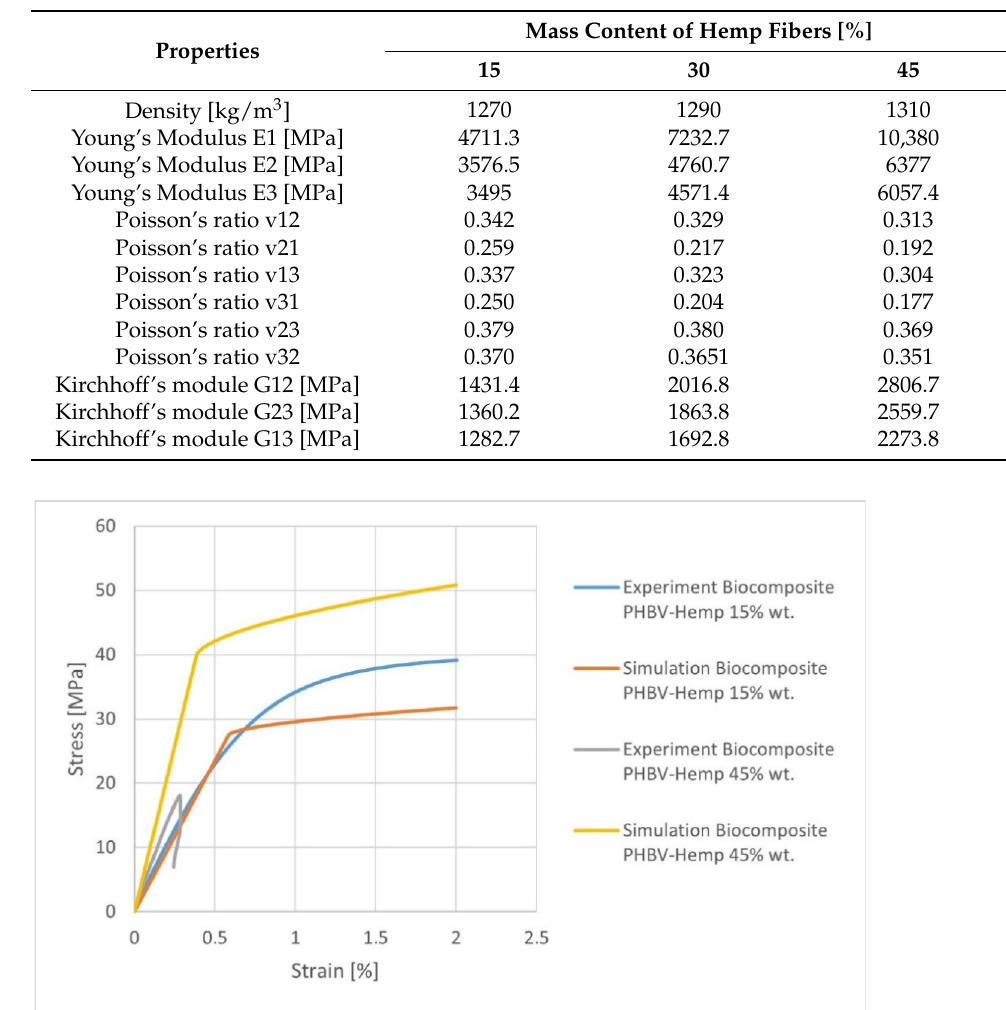
Table 11. The predicted properties of the biocomposite PHBV-hemp fiber for variable types of fiber geometry in RVE.